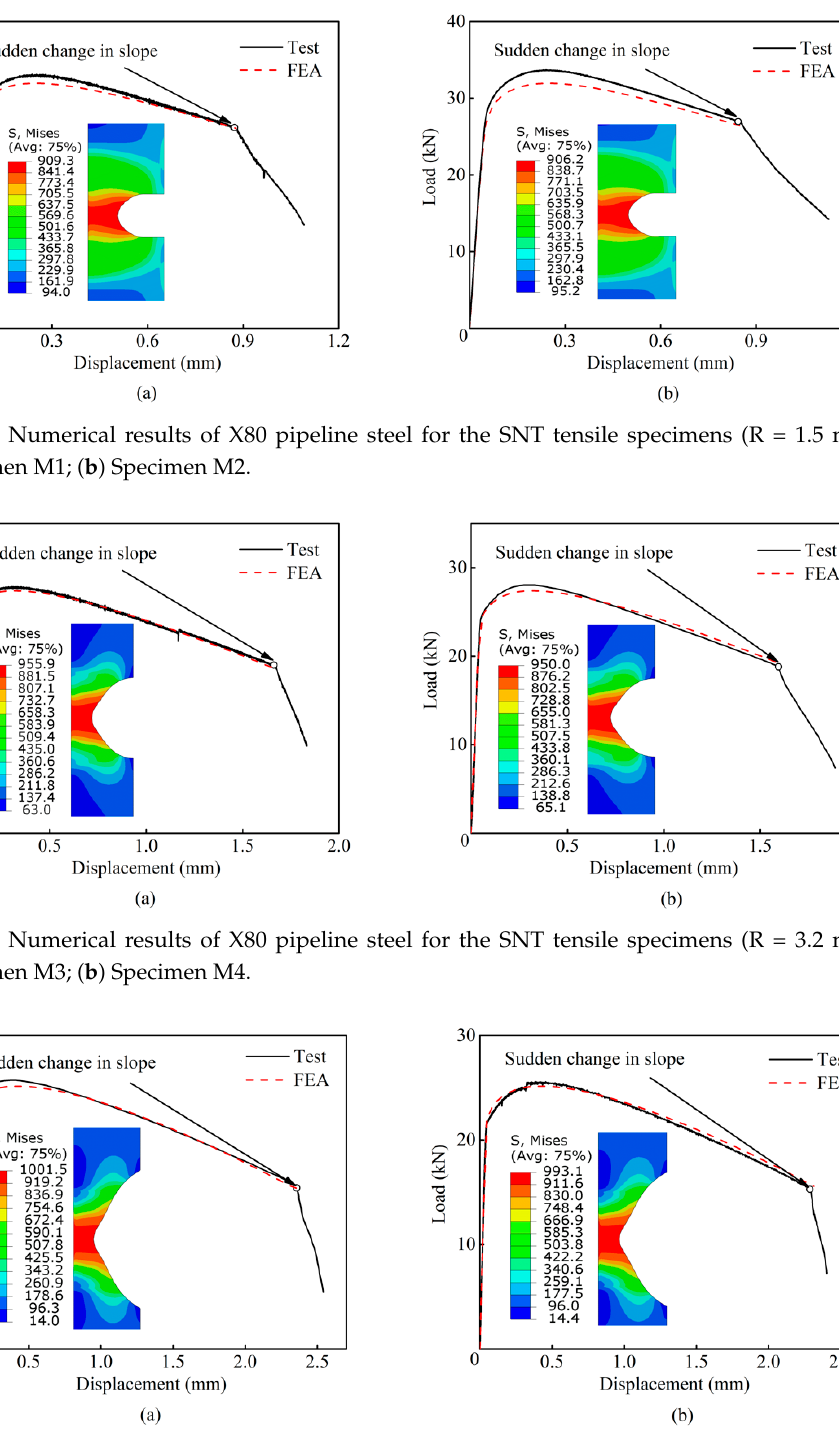
Figure 8. Numerical results of X80 pipeline steel for the SNT tensile specimens (R = 6.3 mm): ( a ) Specimen M5; ( b ) Specimen M6.